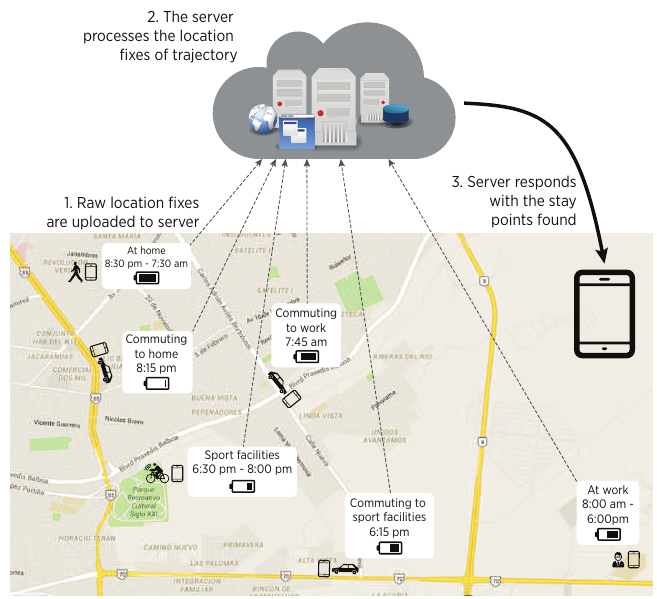
Figure 1. A typical MCC approach for stay points